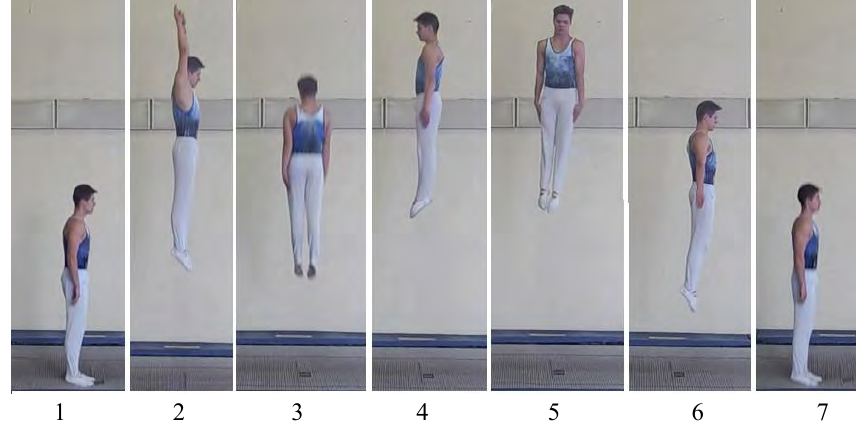
Fig.6. Jump with left turn by 360°